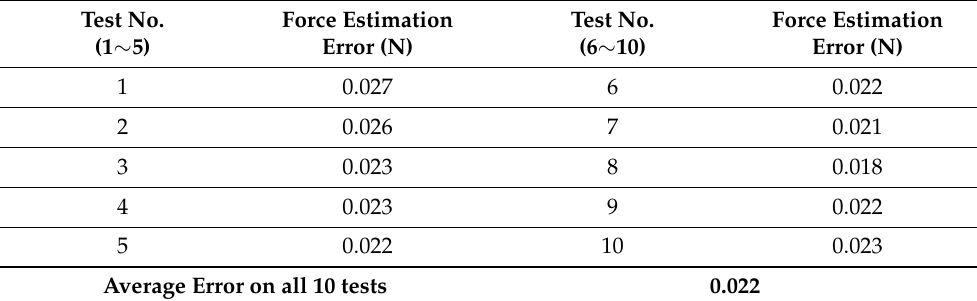
Table 5. Force estimation errors; Each error reading is an average of force estimation error recorded under the force range (0.1 N ∼ 1 N) with 0.1 N interval for each test. Test No.